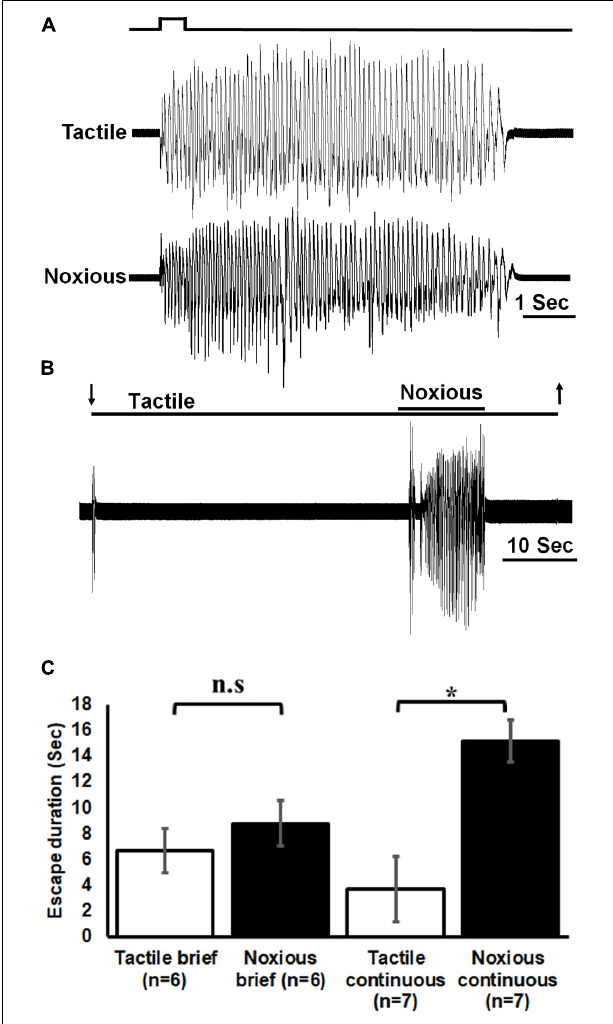
FIGURE 2 | Noxious stimulus induces a nocifensive escape response. (A) Leg movements (which represent escape) of a cockroach in response to brief (0.5 s) tactile (upper trace) and noxious (lower trace) stimuli to the abdomen. Stimulus duration is indicated. (B) Leg movements in response to continuous tactile and noxious stimuli to the abdomen. Stimulus duration is indicated with horizontal lines and arrows (upper line: noxious; lower line: tactile). (C) Brief noxious and tactile stimuli display similar escape response. Continuous noxious stimuli induces a significantly higher escape duration than continuous tactile stimuli. Bars represent means ± SEM, significance is indicated with asterisk or with n.s. stimuli was also stronger for all types of stimuli ( Figure 3B ;